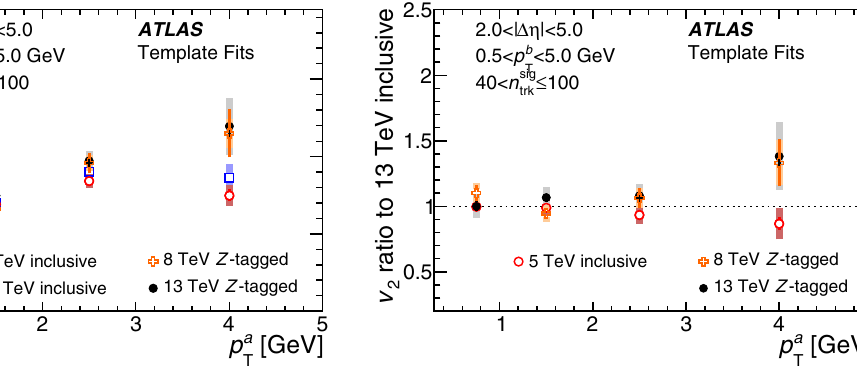
Fig. 12 Left panel: the pile-up-corrected v 2 values obtained from the templatefitsasafunctionof p T .Forcomparison,the v 2 valuesobtained in 5 and 13 TeV inclusive pp data are also shown. The error bars and shaded bands indicate statistical and systematic uncertainties, respec-